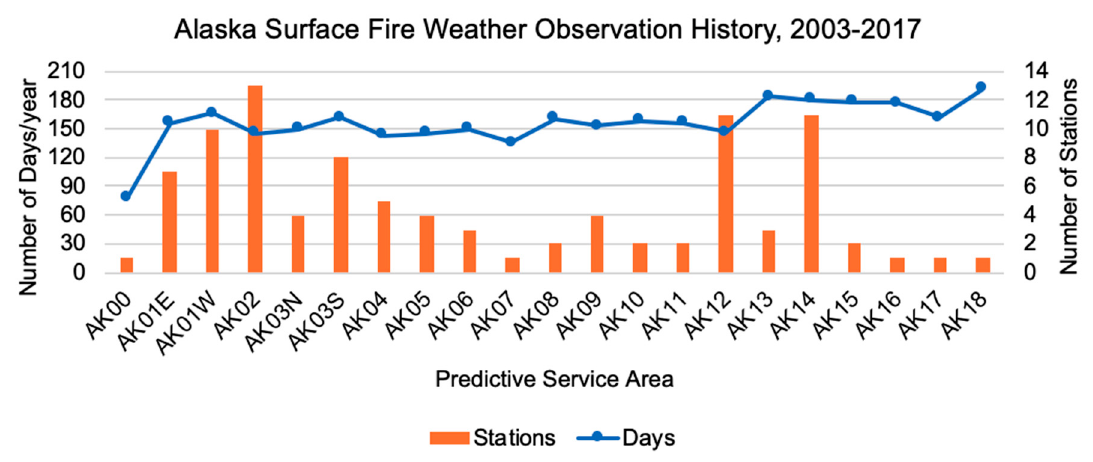
Figure 3. Surface observation history presents average observation days per year (blue line) and number of stations (orange bars) shown for each PSA.